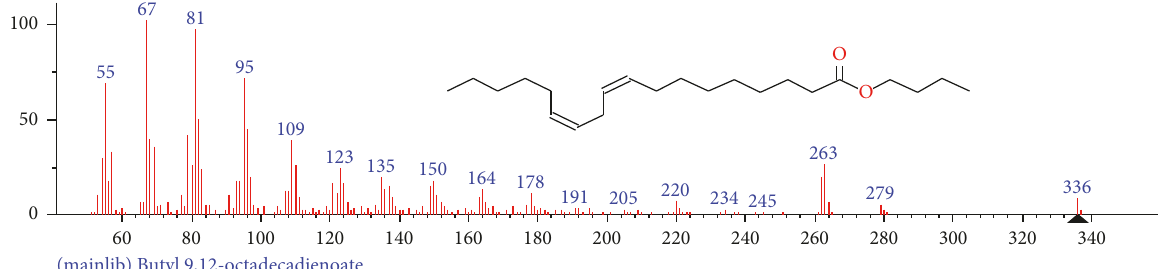
Figure 49: Mass spectrum of compound butyl 9,12-octadecadienoate of whole plant hexane fraction of Achillea wilhelmsii